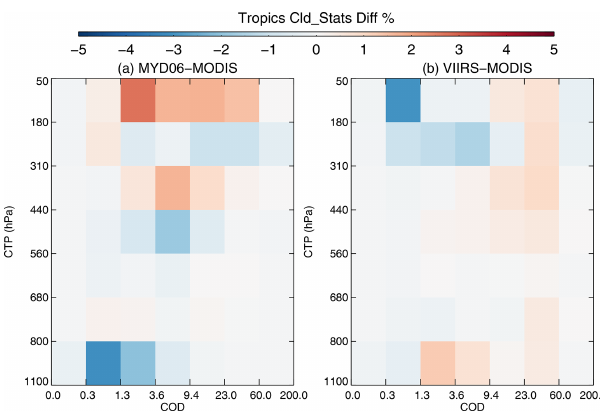
Figure 14. Differences of the imager CTP–COD cloud histograms in the tropics: between the MYD06 and Aqua MODIS continuity products (a) and between the Aqua MODIS and SNPP VIIRS con- tinuity cloud products (b)